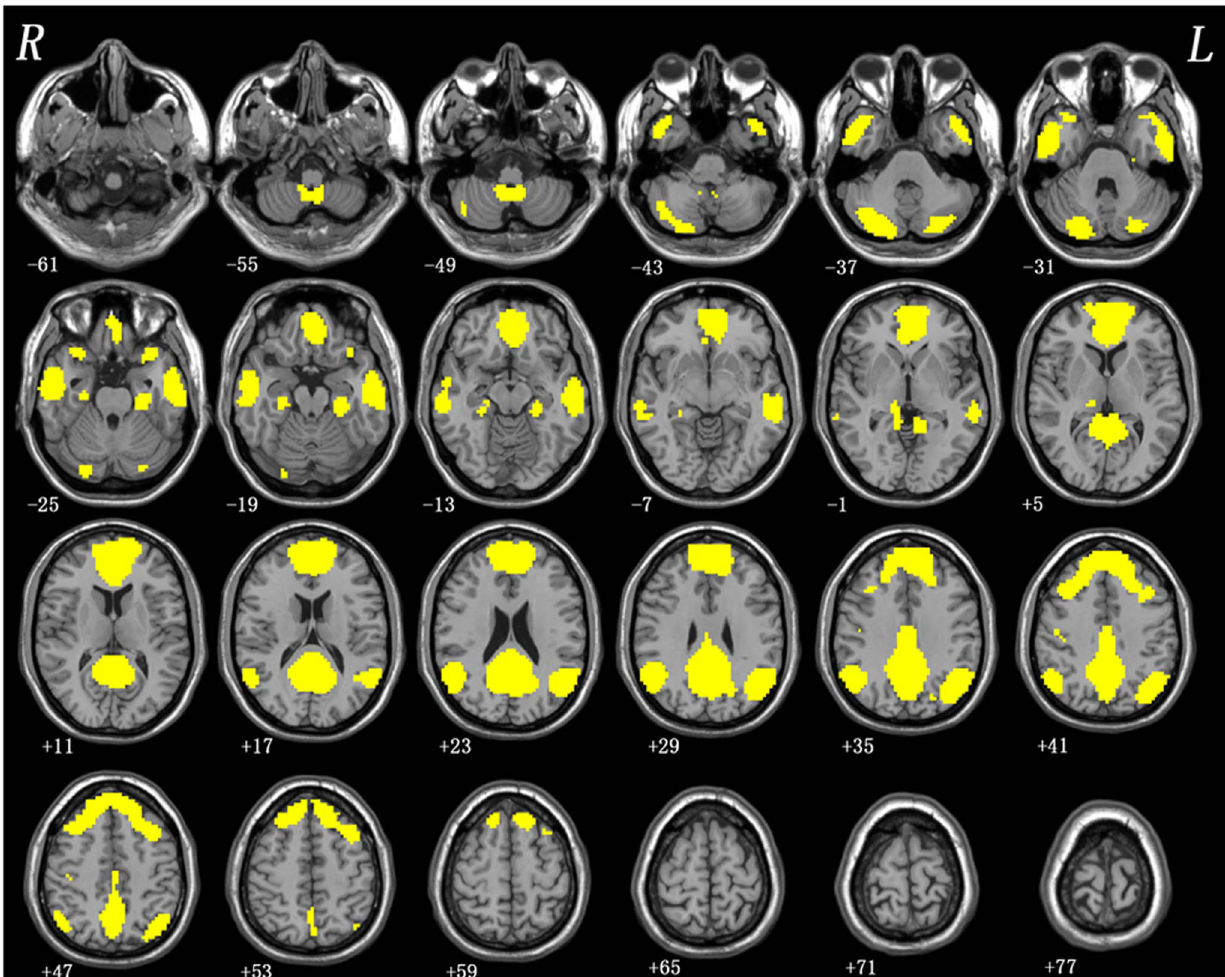
Figure 1. The DMN mask produced in our previous studies. DMN=default mode network.